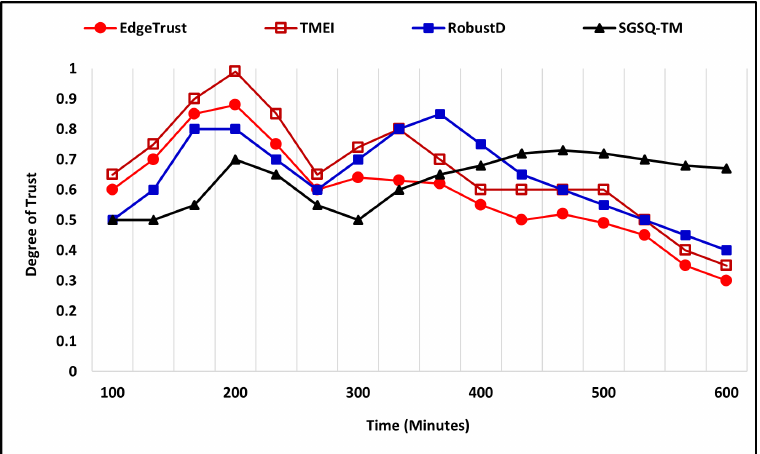
Figure 10. Good mouthing attacks with varying nodes (Scenario-1).